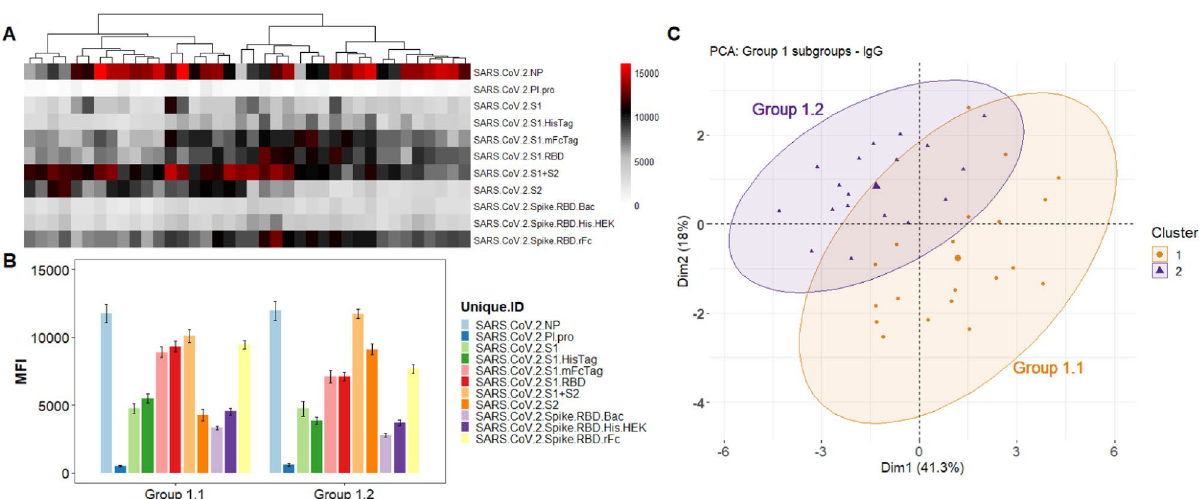
Figure 4. Group 1 Cluster Analysis and PCA demonstrates two subgroups. ( A ) Heatmap showing the reactivity to the SARS-CoV-2 antigens. Samples were clustered using the hierarchical clustering analysis. The dendrogram was cut (and color coded) to a final cluster number equal 3. On ( B ), a bar graph showing the mean reactivity and the standard error of each cluster to each individual SARS-CoV-2 antigen. ( C ) PCA analysis showing the spatial distribution of the samples classified as 1.1 and 1.2 for the first and second principal components. This figure was generated using the R programing language, version 4.0.2 (https:// www.r- proje ct.